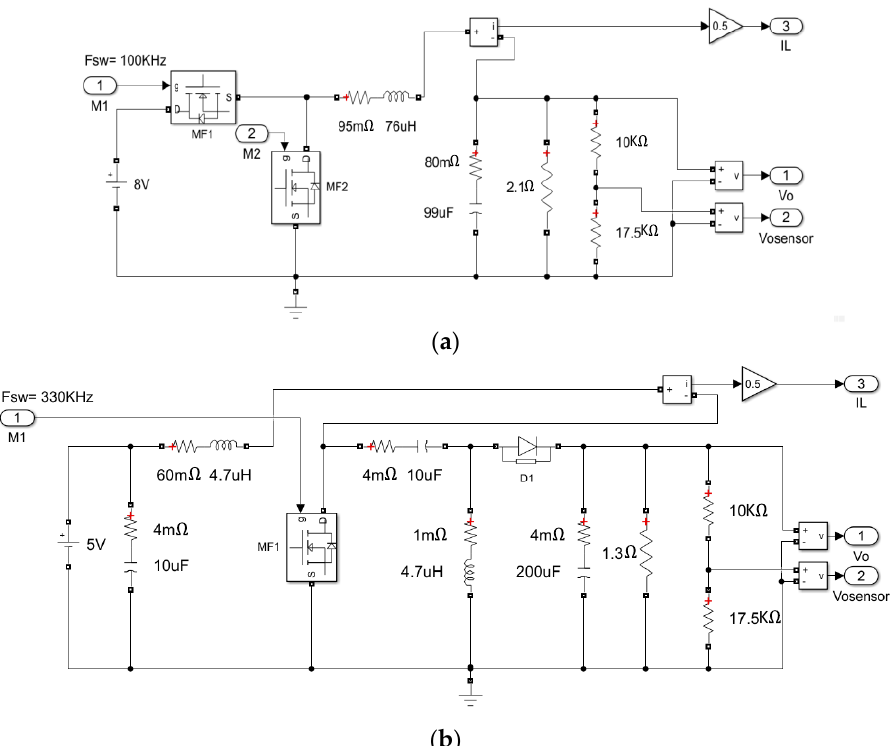
Figure 7. Matlab-Simulink schematics of the simulated converters with the corresponding parameter value. ( a ) Buck converter. ( b ) SEPIC converter.